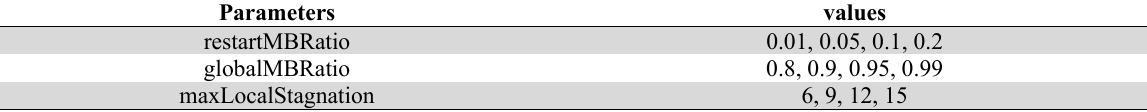
The value of parameters of the Taguchi design for problem